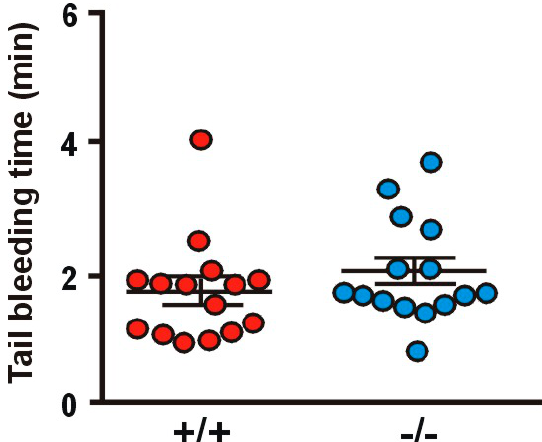
Figure 8. Tail bleeding time. Tests were performed by cutting off 2 mm of the tail tip and immediately placing the tail in PBS at 37 °C. The time until hemostasis was recorded for up to 10 min and re-bleeding monitored for 60 s beyond hemostasis. Data represent mean ± SEM of 15 animals. No significant differences were found between WT and KO (Student’s t -test).